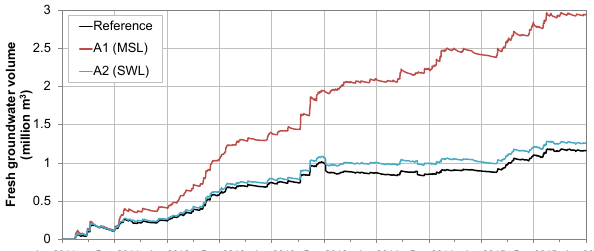
Figure 9. Change in the volume of fresh groundwater from June 2011 to May 2016 for the calibrated model (reference case) and model convergence simulations S1, S2, and S3.